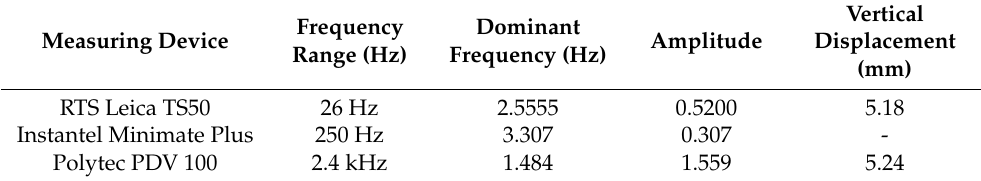
Table 9. Analysis: laboratory monitoring